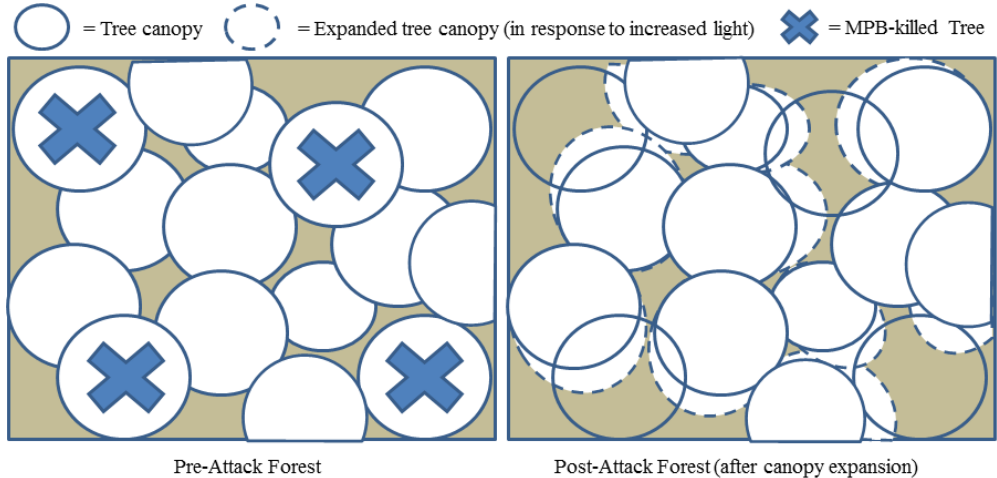
Fig. 7. Remaining canopy and subcanopy trees can be expected to expand in response to increased light availability post-MPB attack; however we can anticipate that the capacity of this expansion will be